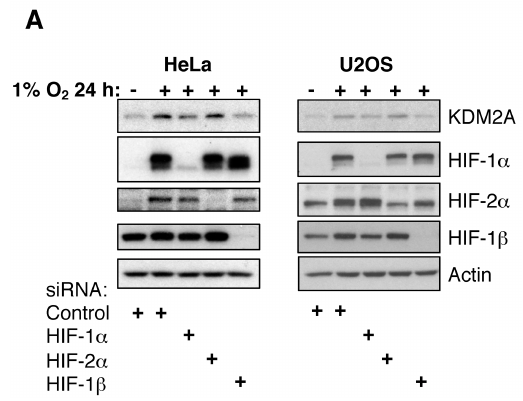
Figure 3. Cont. Figure 3.